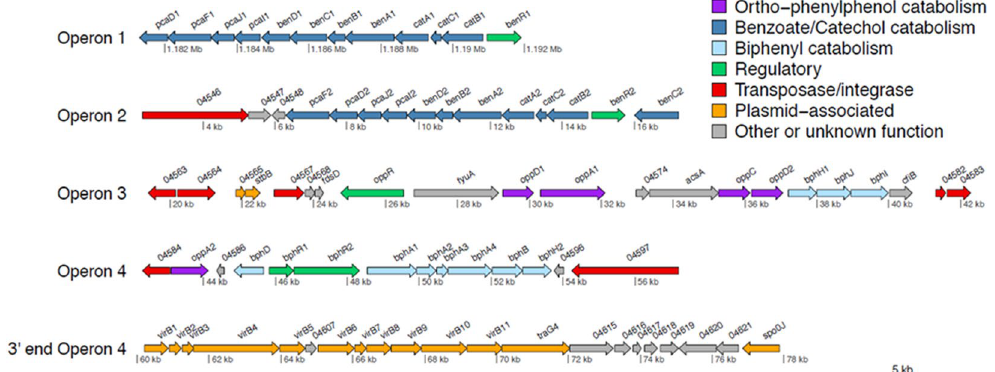
Figure 1. Genetic organization of operons 1, 2, 3 and 4 containing genes involved in the transformation of OPP by Sphingomonas haloaromaticamans strain P3. Operon 1 is located in scaffold 1 which represents the bacterial chromosome (4.5 Mb) and encodes a complete ortho - cleavage pathway for benzoic acid (BA). Operons 2, 3 and 4 are located in the 92-kb scaffold 3 and encode (2) a second complete ortho - cleavage pathway for BA, (3) enzymes with a putative role in the upper pathway of OPP, and a lower biphenyl ( bph ) pathway, and (4) an incomplete upper bph pathway. The genomic region downstream of the 3 ′ end of operon 4 encoding genes of the type IV secretion system and other plasmid conjugation proteins is also shown. Annotation of the different ORFs is shown in Table